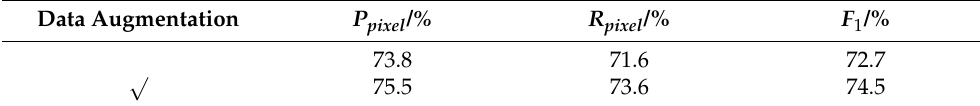
Figure 11. Different types of data augmentation methods. ( a ) Original Image; ( b ) Flipping Transfor- mation; ( c ) Contrast Transformation; ( d ) Random Cropping; ( e ) Noise. Table 5. The comparison results of data augmentation.